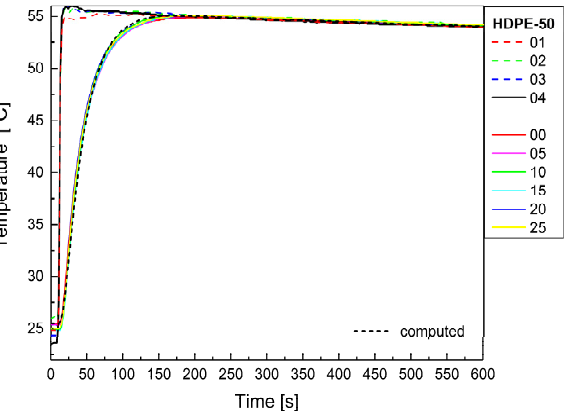
Figure 16. Time-history of measured temperatures and the temperatures computed in the probe axis (measurement A — water bath temperature of 55 °C/probe 2).